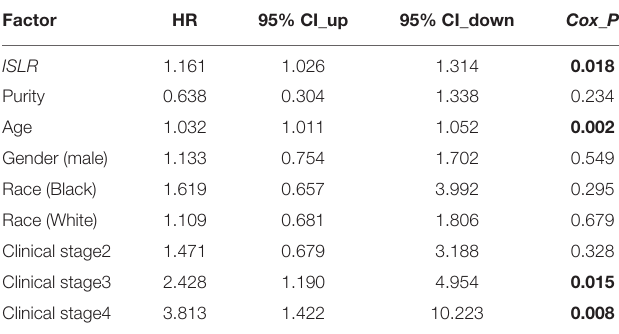
TABLE 2 | Correlation of ISLR expression and the clinical prognosis of gastric cancer patients in the TCGA-STAD cohort (Cox proportional hazard model). Factor HR 95% CI_up 95% CI_down Cox_P